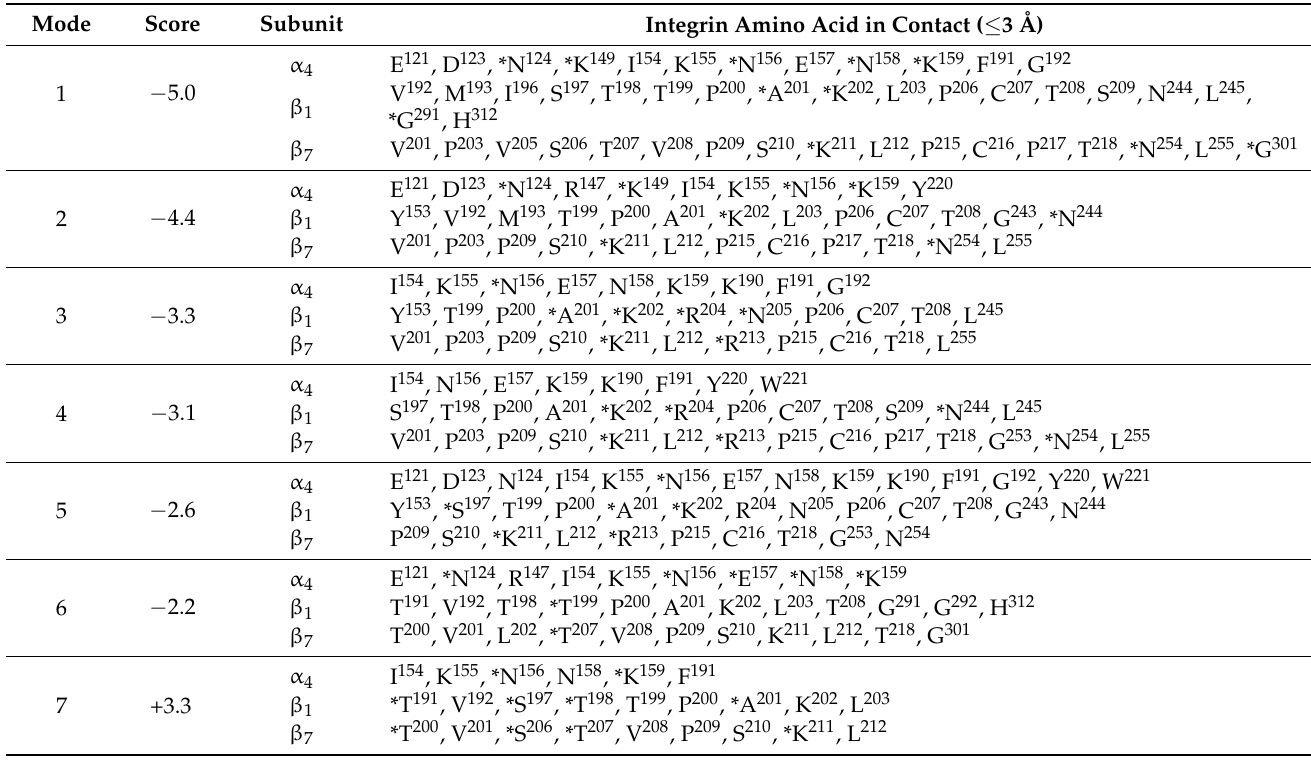
Table 1. Predicted integrin α 4 β 1 / β 7 amino acids with contact with the EDA-FN